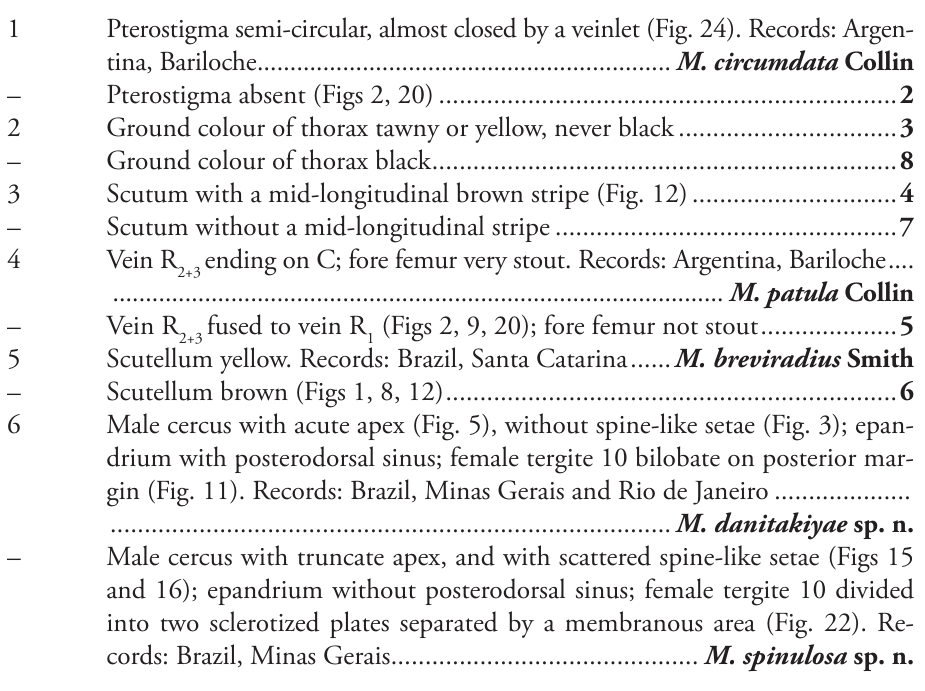
Key to the Neotropical species of